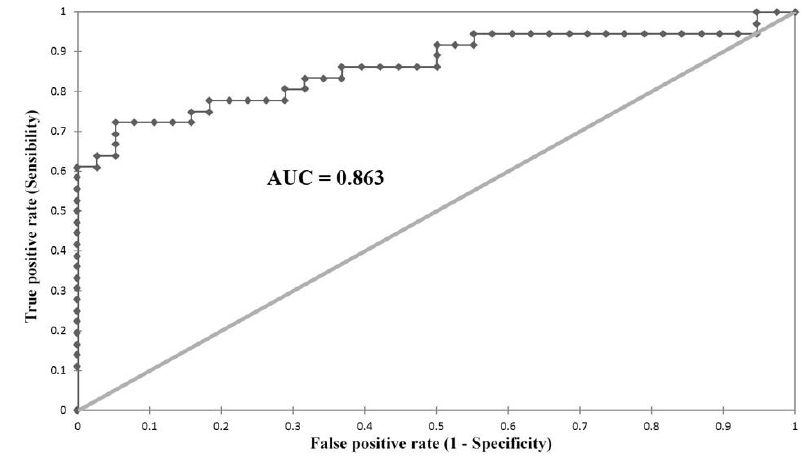
Figure 2. ROC curve evaluating SHI values for the diagnosis of ALS.